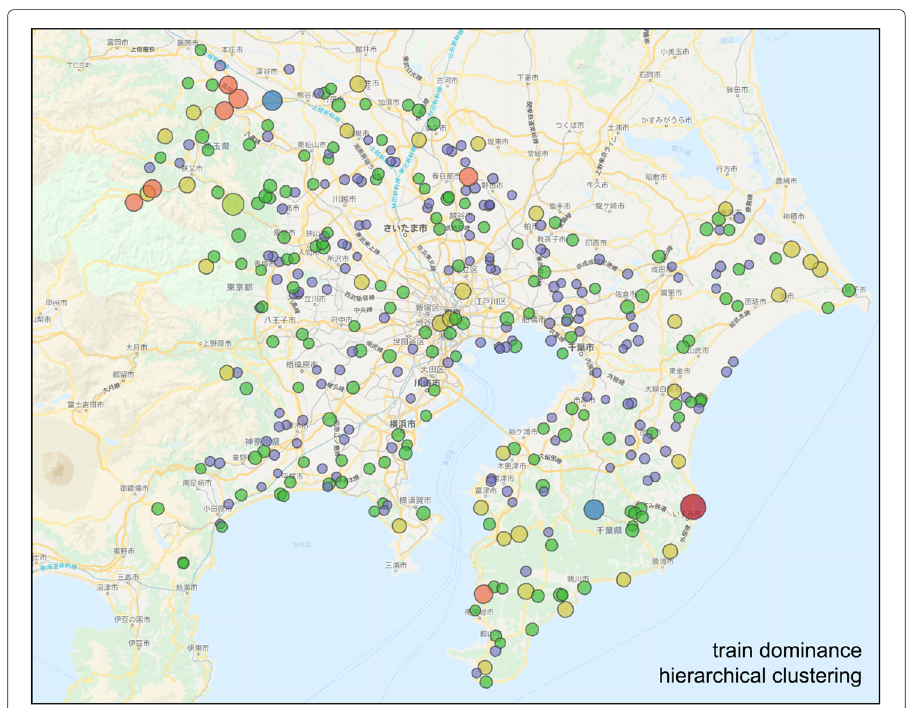
Fig. 15 Remaining locations grouped by their rail dominance scores with sizes representing the score and colors indicating group membership. Map data ©2019